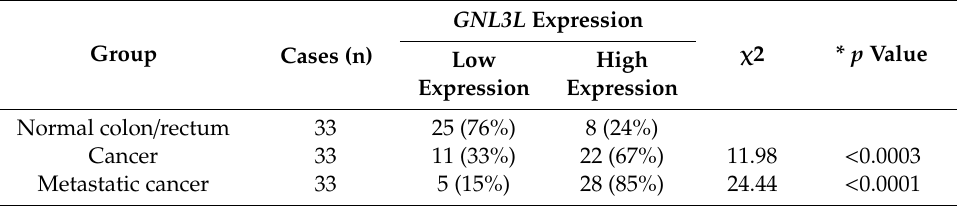
Table 1. The expression of GNL3L in CRC compared to normal colon tissues. GNL3L Expression χ 2 * p ValueLow High Group Cases (n) Expression Expression Normal colon / rectum 33 25 (76%) 8 (24%) Cancer 33 11 (33%) 22 (67%) 11.98 < 0.0003